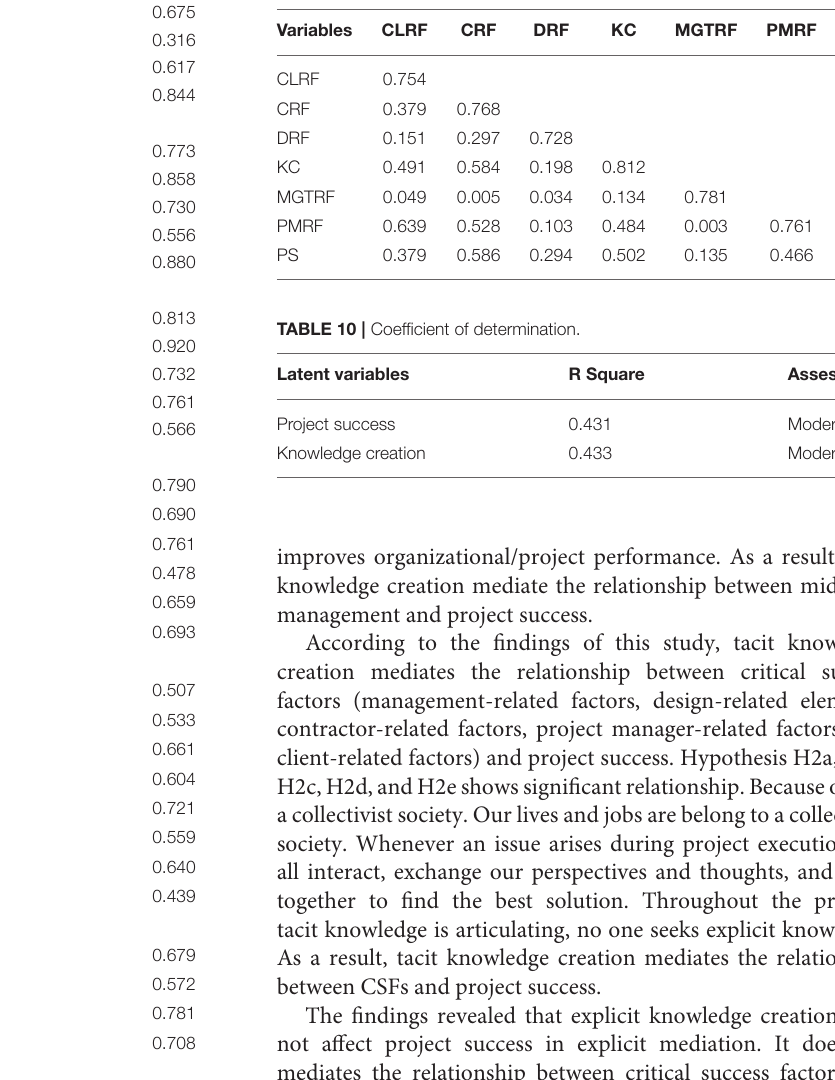
TABLE 9 | Fornell and Larcker criterion.